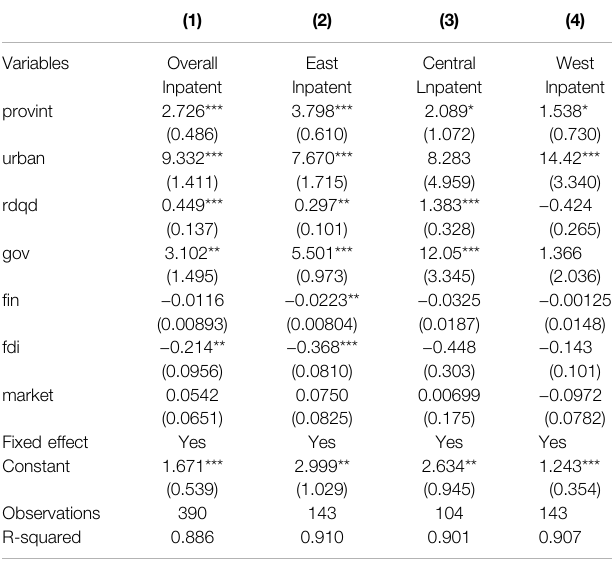
TABLE 5 | Benchmark regression results of innovation spillover effect in an industrial Internet development environment.